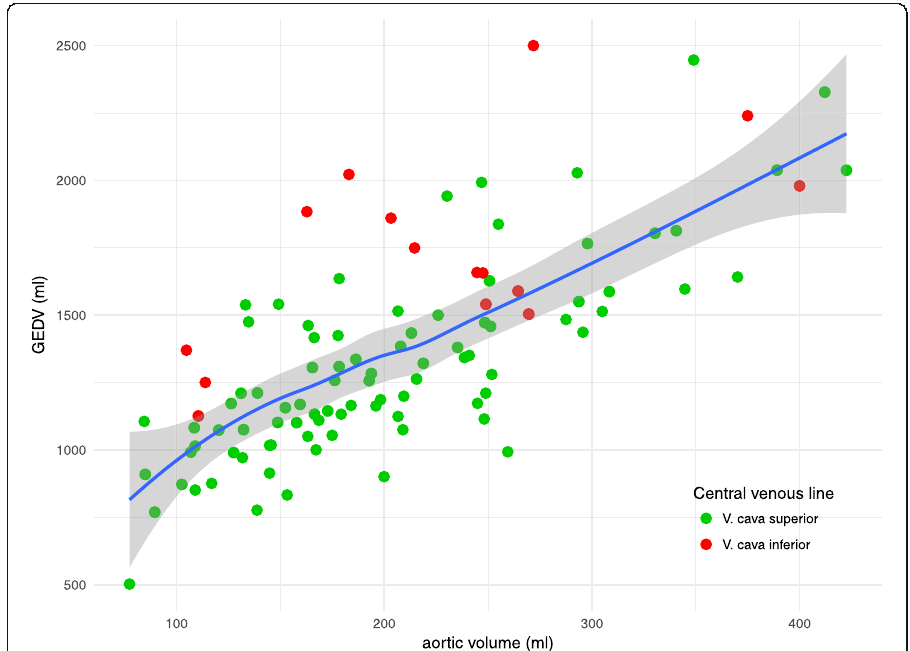
Fig. 3 Relationship of global end-diastolic volume (GEDV) and aortic volume. Blue line indicates the regression line, with its 95% confidence interval marked in grey. Green dots represent measurements with central venous lines placed in the vena cava superior, red dots in the vena cava